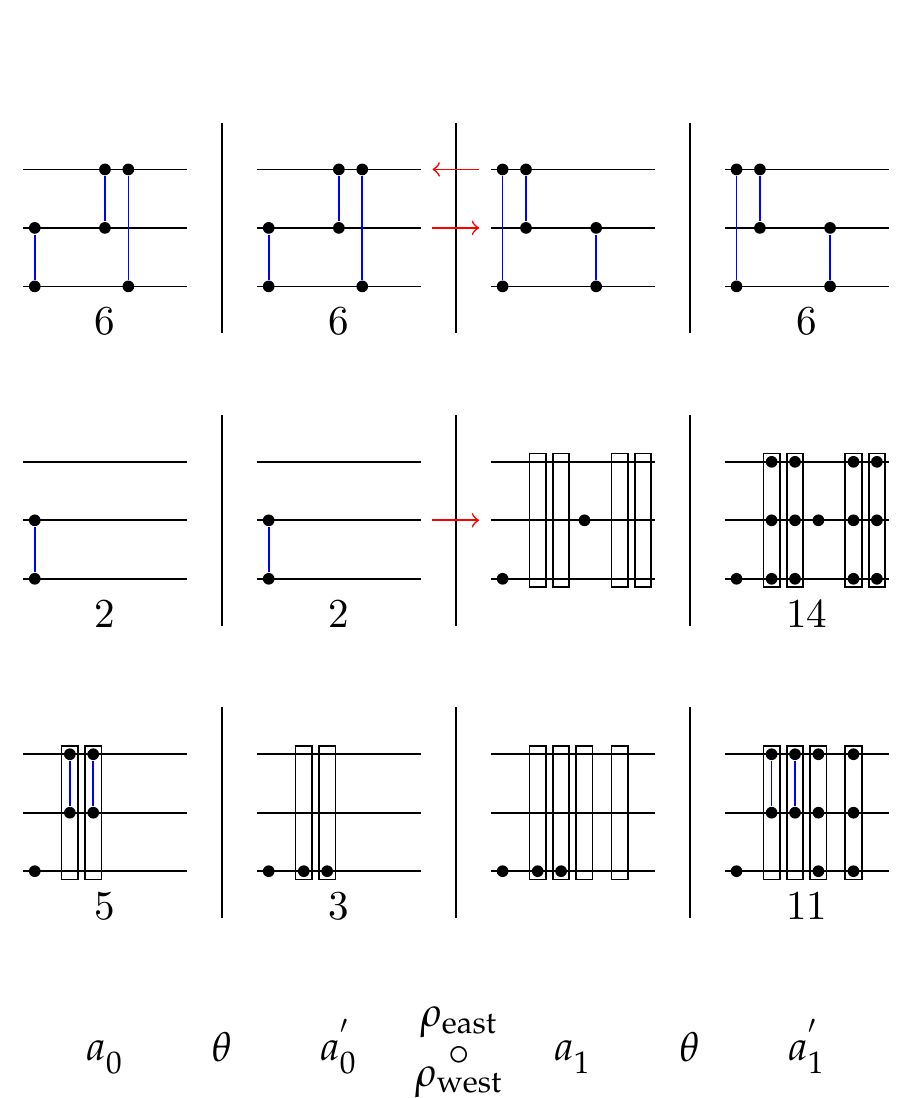
Figure 8: Schematics of three types of inherent trails: vortex (top), single-orbital fan (middle) and θ 2 glide